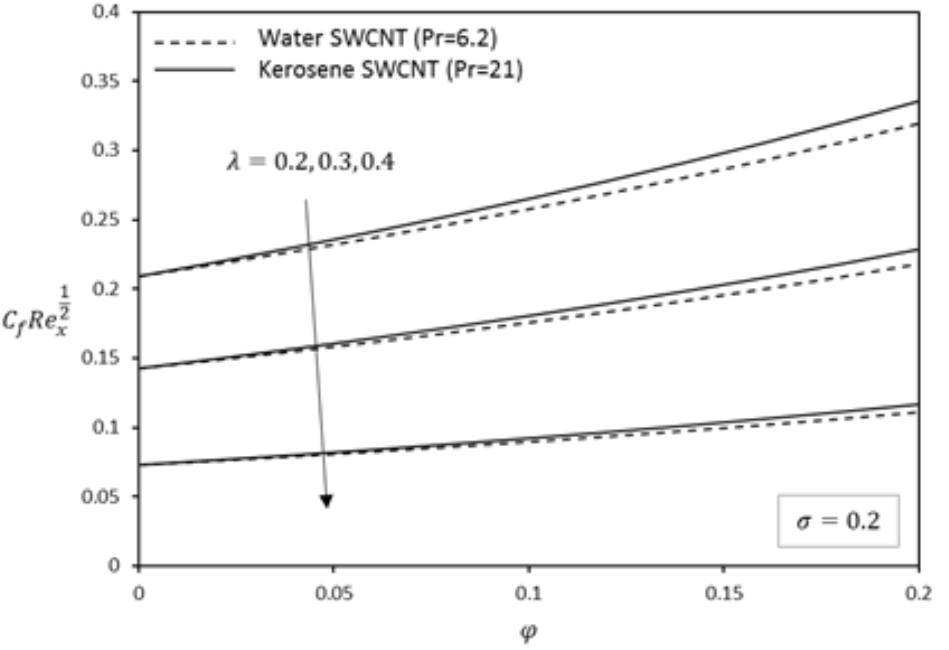
Figure 11. Effect of λ on skin friction for water-kerosene based fluid.